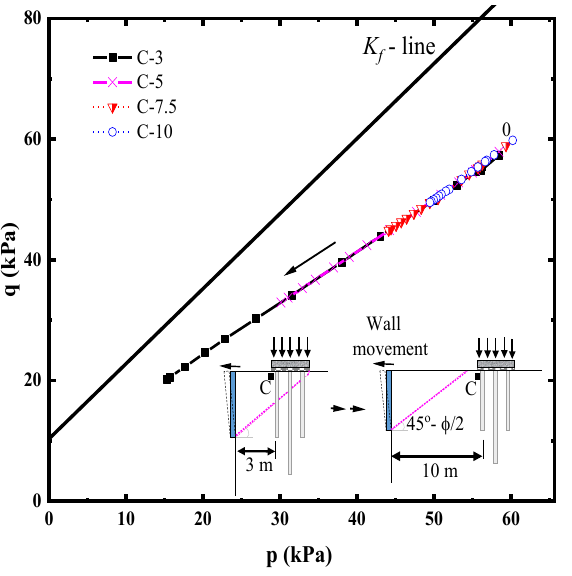
Figure 8 : Stress paths experienced by a soil element for different locations of the composite foundation from the wall.